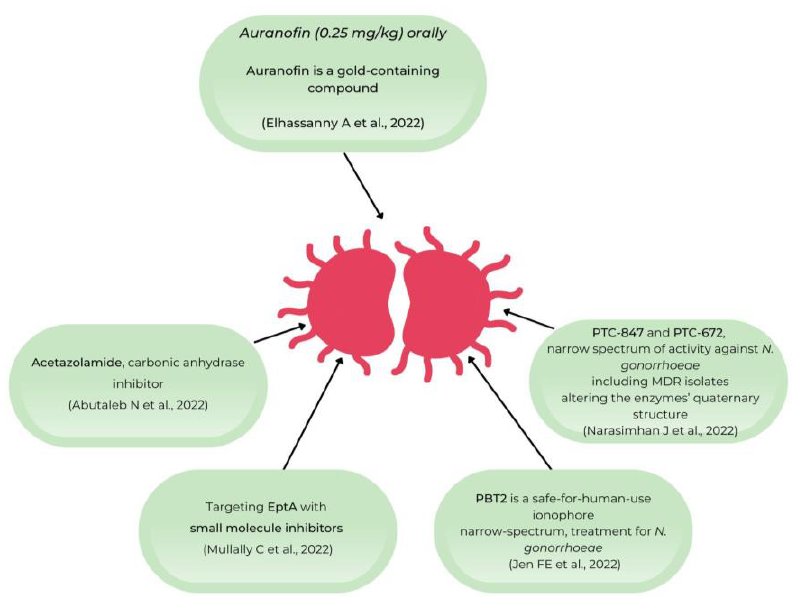
Figure 2. Schematic representation of the new therapeutical drugs against N. gonorrhoeae.